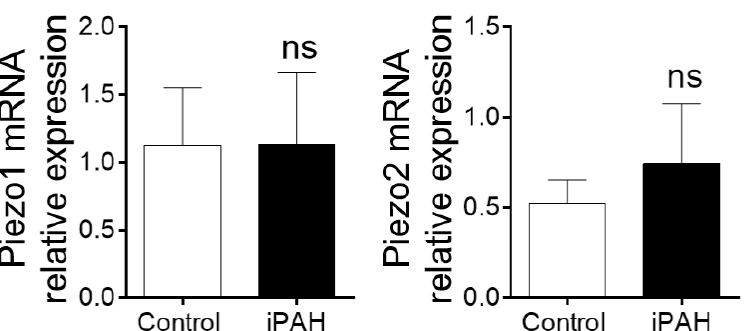
Figure 11. mRNA expression of Piezo1 and Pizeo 2. Unchanged expression of Piezo1 and Piezo2 mRNA expression in isolated pulmonary arteries from control ( n = 5) and iPAH patients ( n = 5). Gene expression was quantified using qPCR following the standard protocol for ready-to-use TaqMan gene expression assays (Life Technologies) on a StepOne Plus Real-Time PCR System (Life Technologies). Piezo1 and Piezo2 mRNA expression were normalized by β-Actin mRNA (Hs00207230_m1, Hs00926218_m1, Hs01060665_g1).